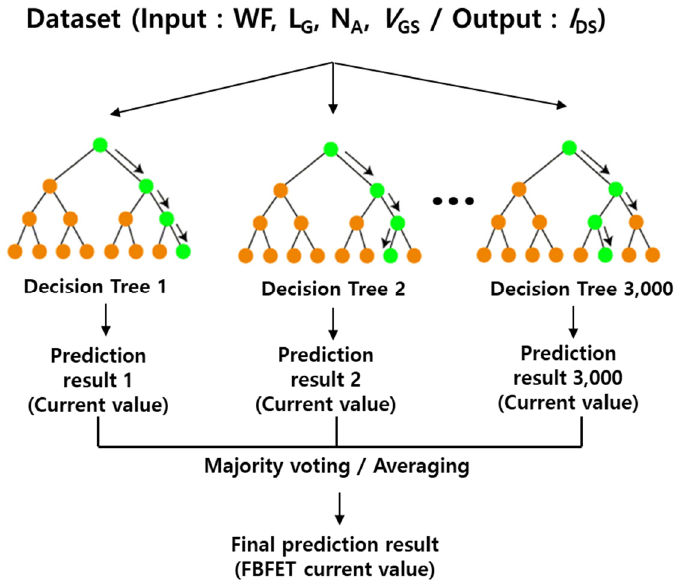
Figure 2. ML framework with a random forest regression algorithm used to predict I DS -V GS charac- teristics. A total of 3000 decision trees were used in the experiments.